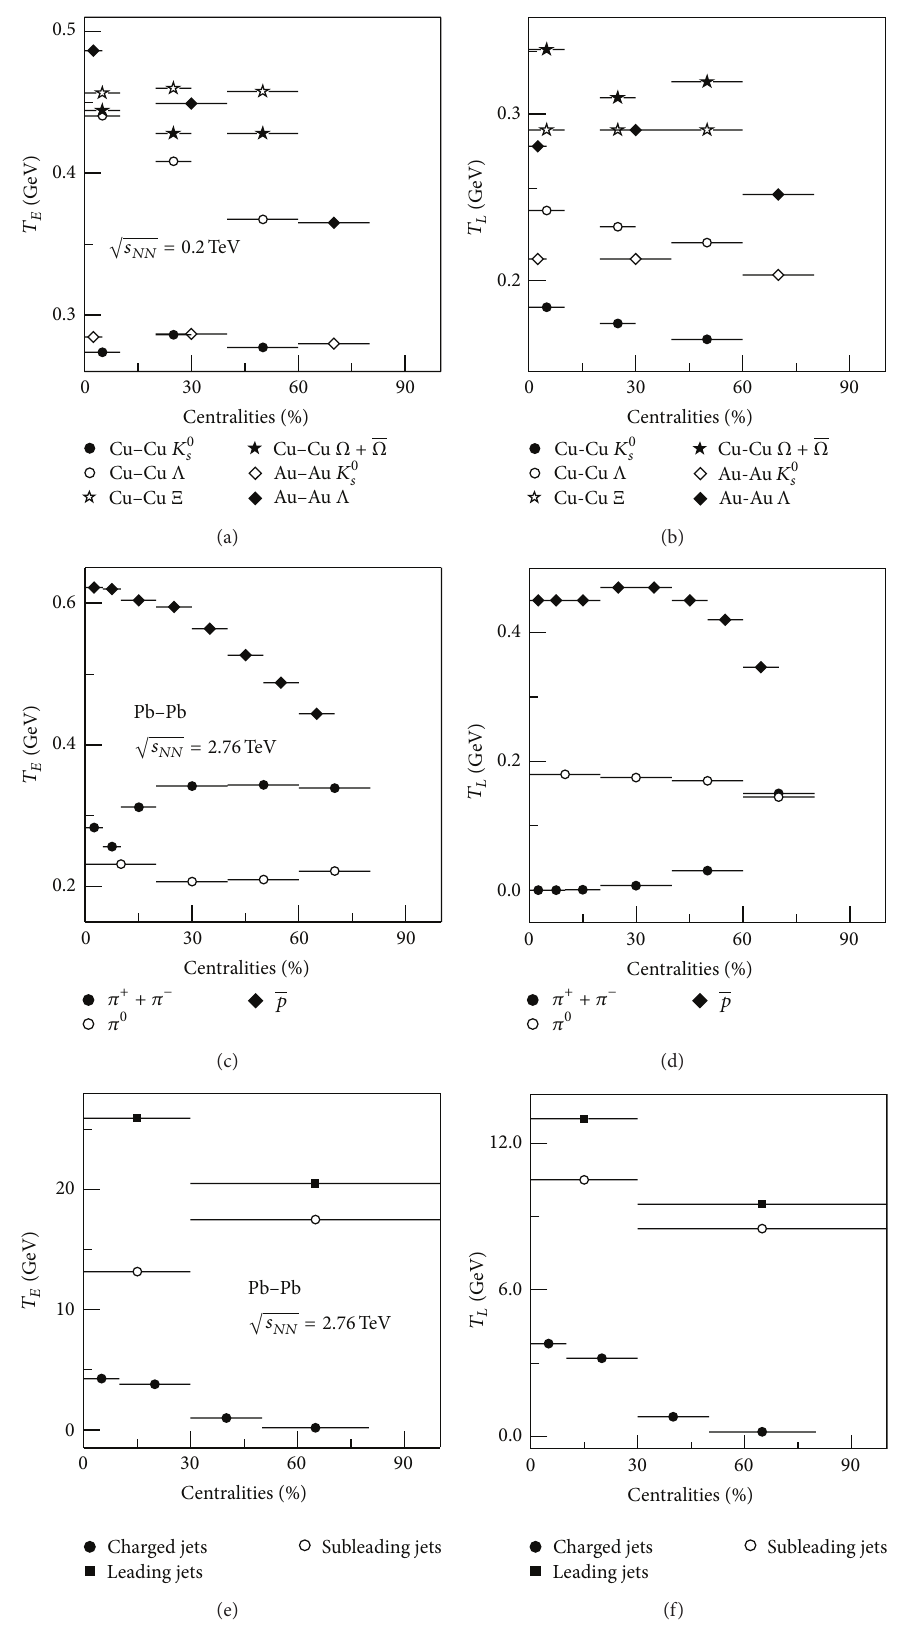
Figure 11: Dependences of temperatures 𝑇 𝐸 and 𝑇 𝐿 on centrality. (a), (b), (c), and (d) as well as (e) and (f) correspond to dependence on centrality for particle productions at 0.2 and 2.76 TeV and jet production at 2.76 TeV,